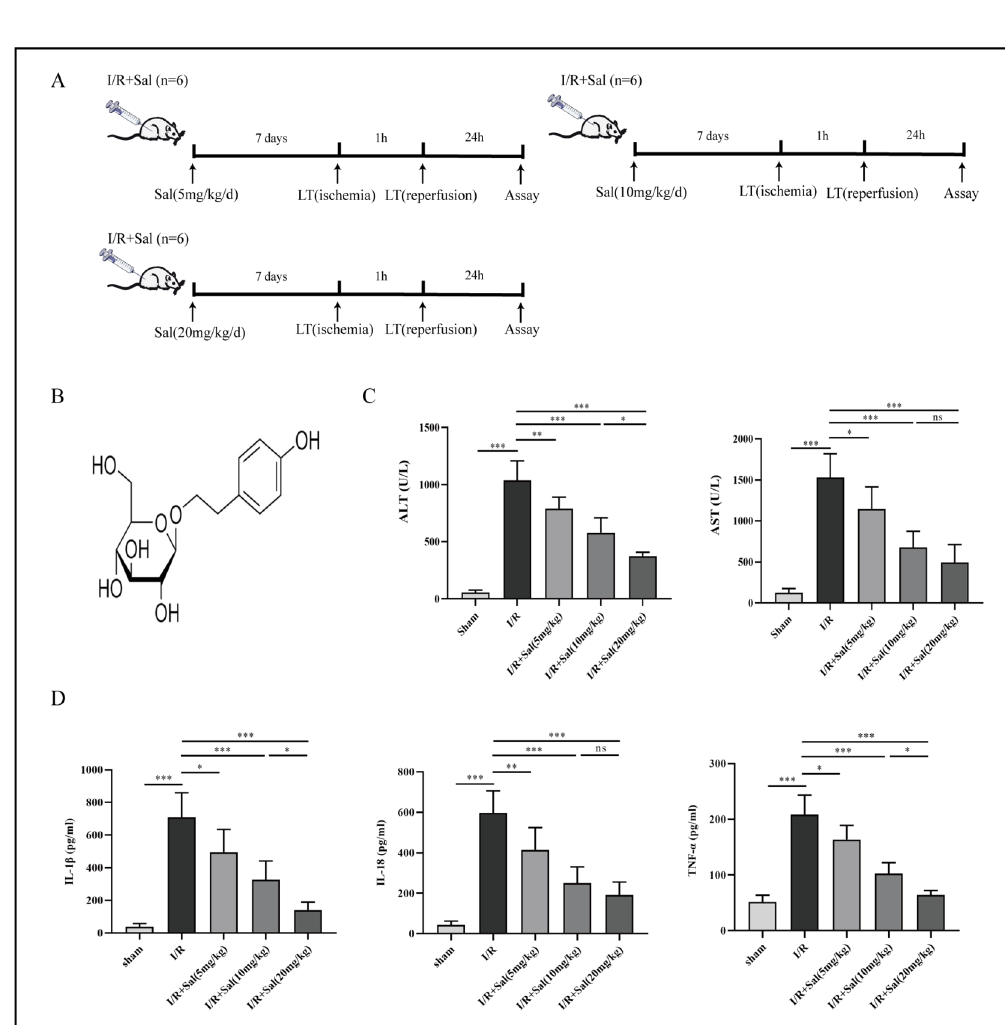
Figure 1. Salidroside improves liver function and decrease inflammatory cytokines in rats after liver transplantation. ( A ) Schematic diagram describing the grouping of the rats. ( B ) Chemical structure of salidroside. ( C ) Serum levels of ALT and AST in different groups. ( D ) Serum levels of inflammatory cytokines in different groups. The statistical differences among groups were assessed by one-way ANOVA. ns P > 0.05, * P < 0.05, ** P < 0.01, *** P <